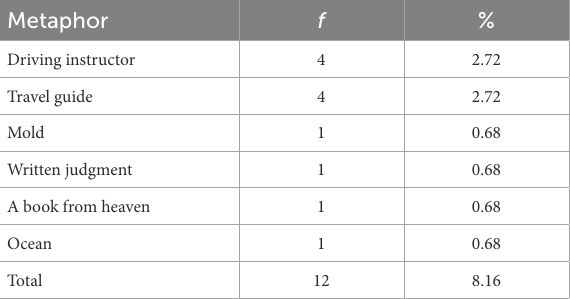
TABLE 6 Frequency and percentage of the textbook metaphor in the conceptual category of “teacher-directed.” Metaphor f % Driving